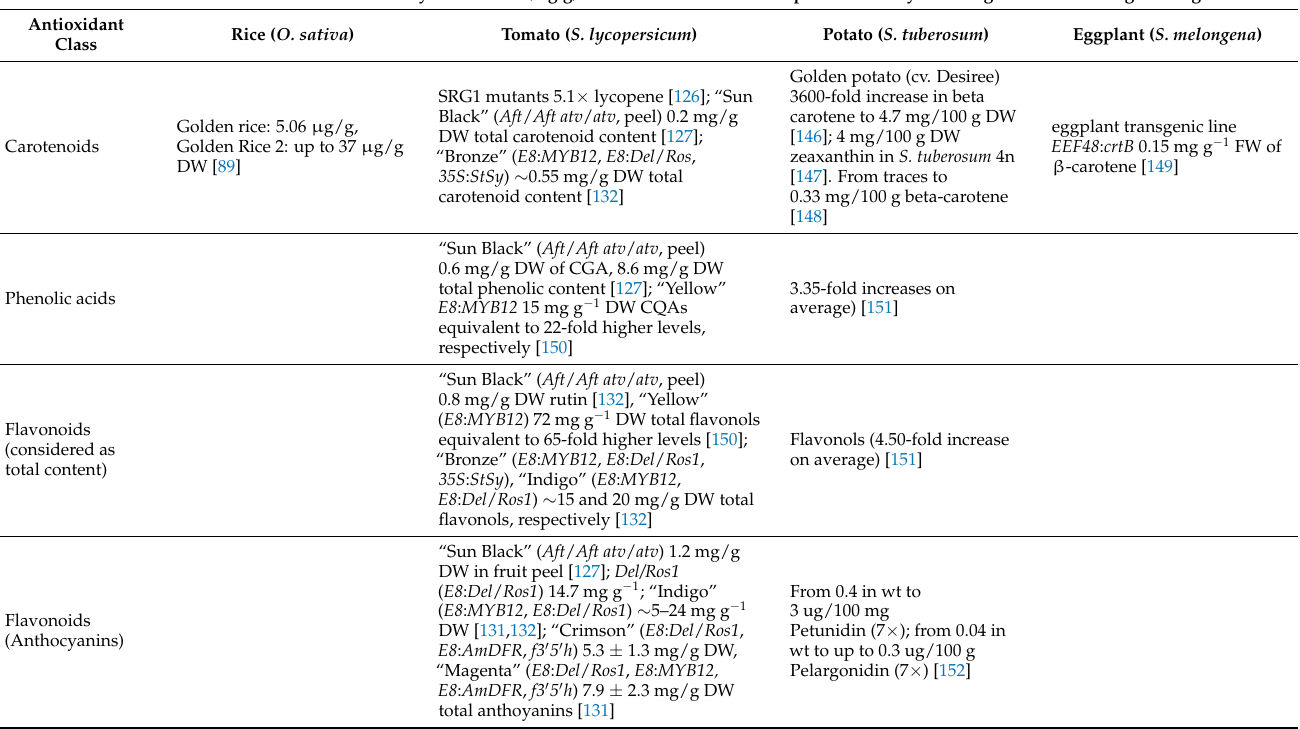
Table 2. Typical range of concentration of phytochemicals in naturally biofortified and metabolic engineered cereal and Solanaceae